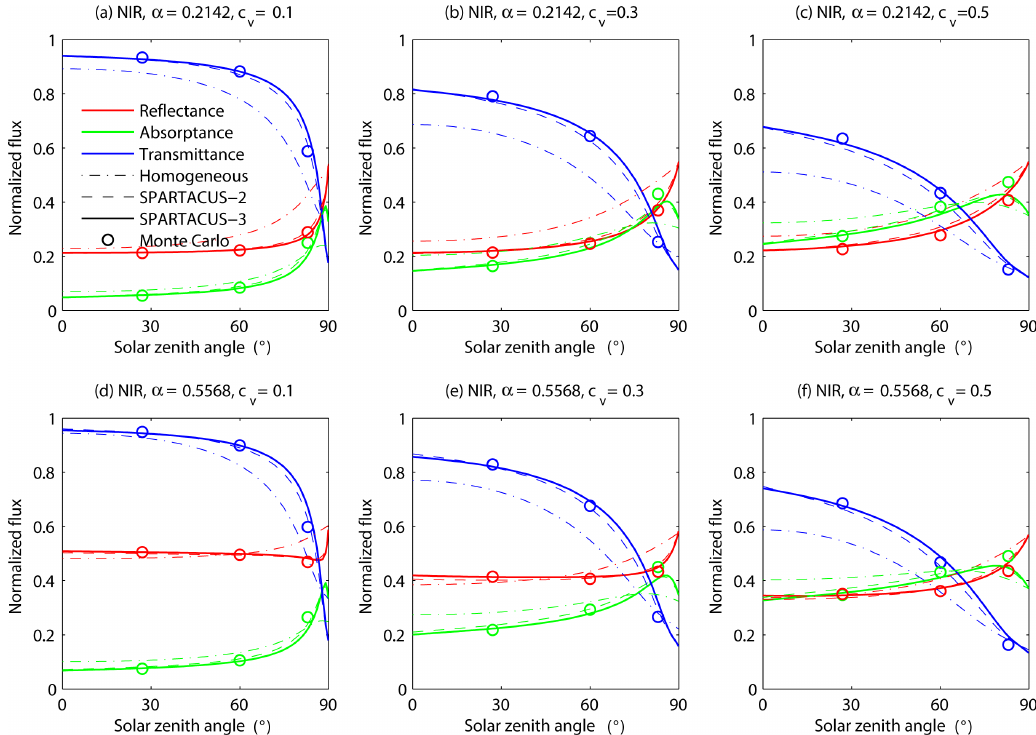
Figure 3. As Fig. 2 but with optical properties appropriate for near-infrared radiation.